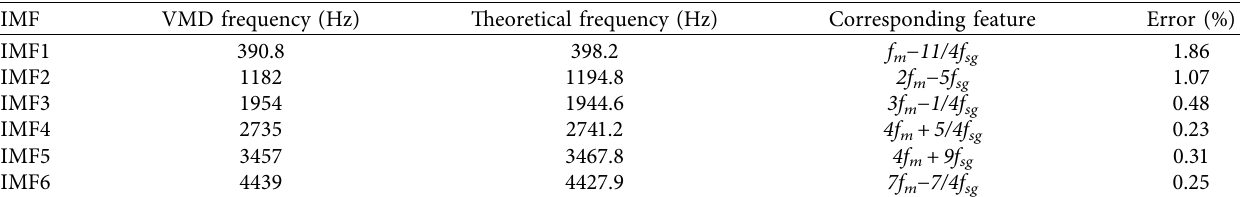
Figure 12: Central frequency and amplitude of each IMF. Table 6: Error between the simulated VMD IMF central frequency and theoretical value for 3 #